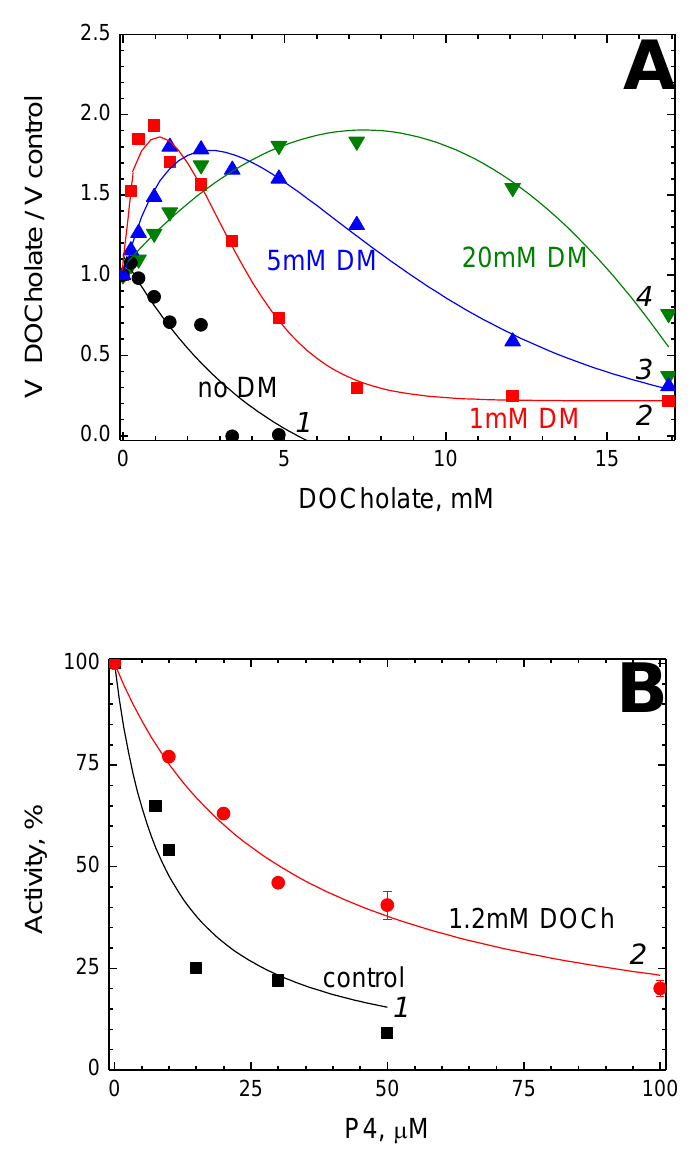
Figure 2. The interaction of P4 with solubilized CcO is affected by deoxycholate. ( A ) The DM- dependent biphasic action of deoxycholate on the CcO activity. The rate of the oxidase reaction (given in the relative units, the ordinate axis) was measured mostly as in Figure 1, but in the presence of different concentrations of deoxycholate (the abscissa axis) and DM. To guide the eye, empirical curves 1–5 are drawn through the experimental points, which correspond to 0, 1 mM, 5 mM and 20 mM DM, respectively. ( B ) The dependence of the oxidase activity on [P4]. Black squares—control, red circles—in the presence of 1.2 mM deoxycholate (DOCh). Other conditions are as in Figure 1.